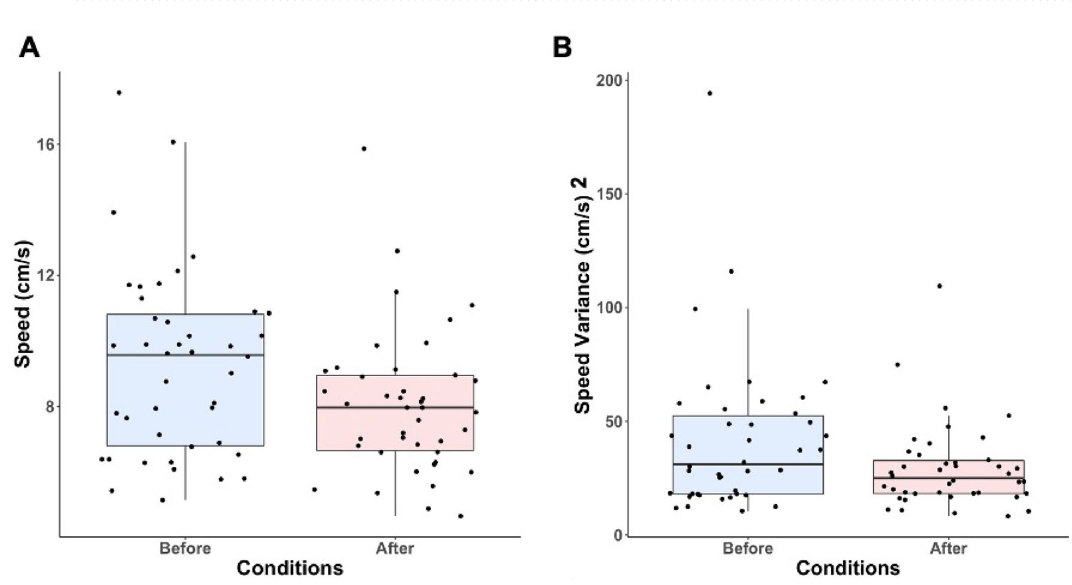
Figure 5. Box plots for speed ( A ) and speed variance ( B ) for before vs after